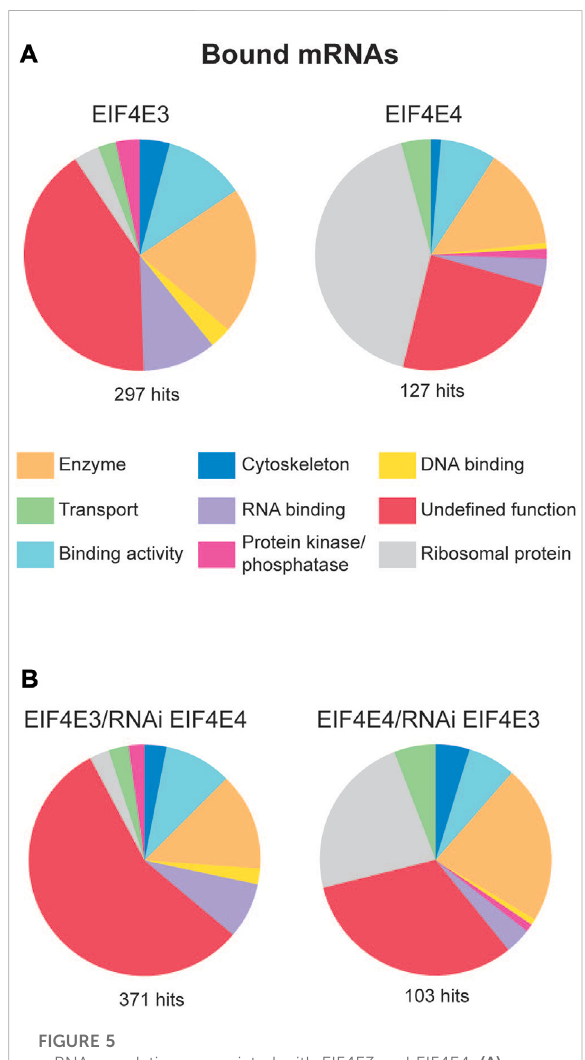
FIGURE 5 mRNA populations associated with EIF4E3 and EIF4E4. (A) mRNA groups associated with EIF4E3 and EIF4E4 from T. brucei (Illumina sequencing). Enriched mRNAs were manually classi fi ed and grouped using the gene ontology (GO) terms according to their molecular function. “ Enriched ” means at least 2-fold more abundant than in the negative control. (B) mRNA groups associated with EIF4E3 after EIF4E4 RNAi, and with EIF4E4